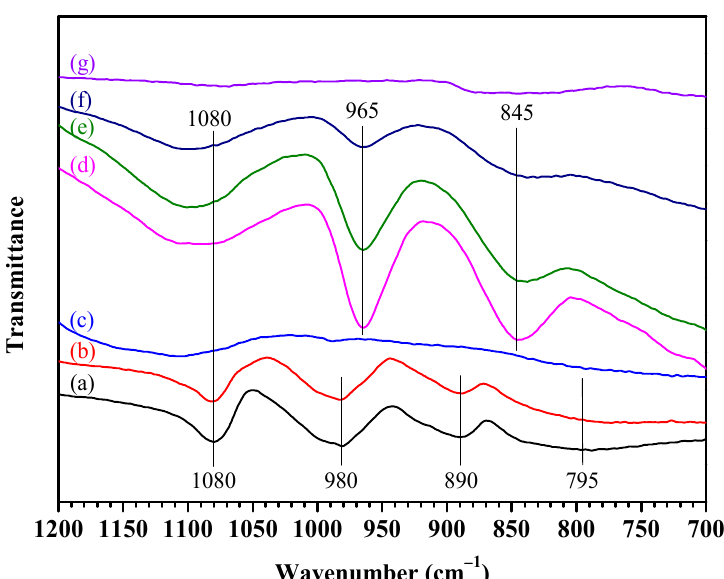
Figure 2. FTIR spectra of HPW before calcinatation (a), HPW calcinated at 400 °C (b) and 650 °C (c); Mn-HPW 0.02 before calcination (d), Mn-HPW 0.02 calcinated at 200 °C (e), 400 °C (f), and 650 °C (g).